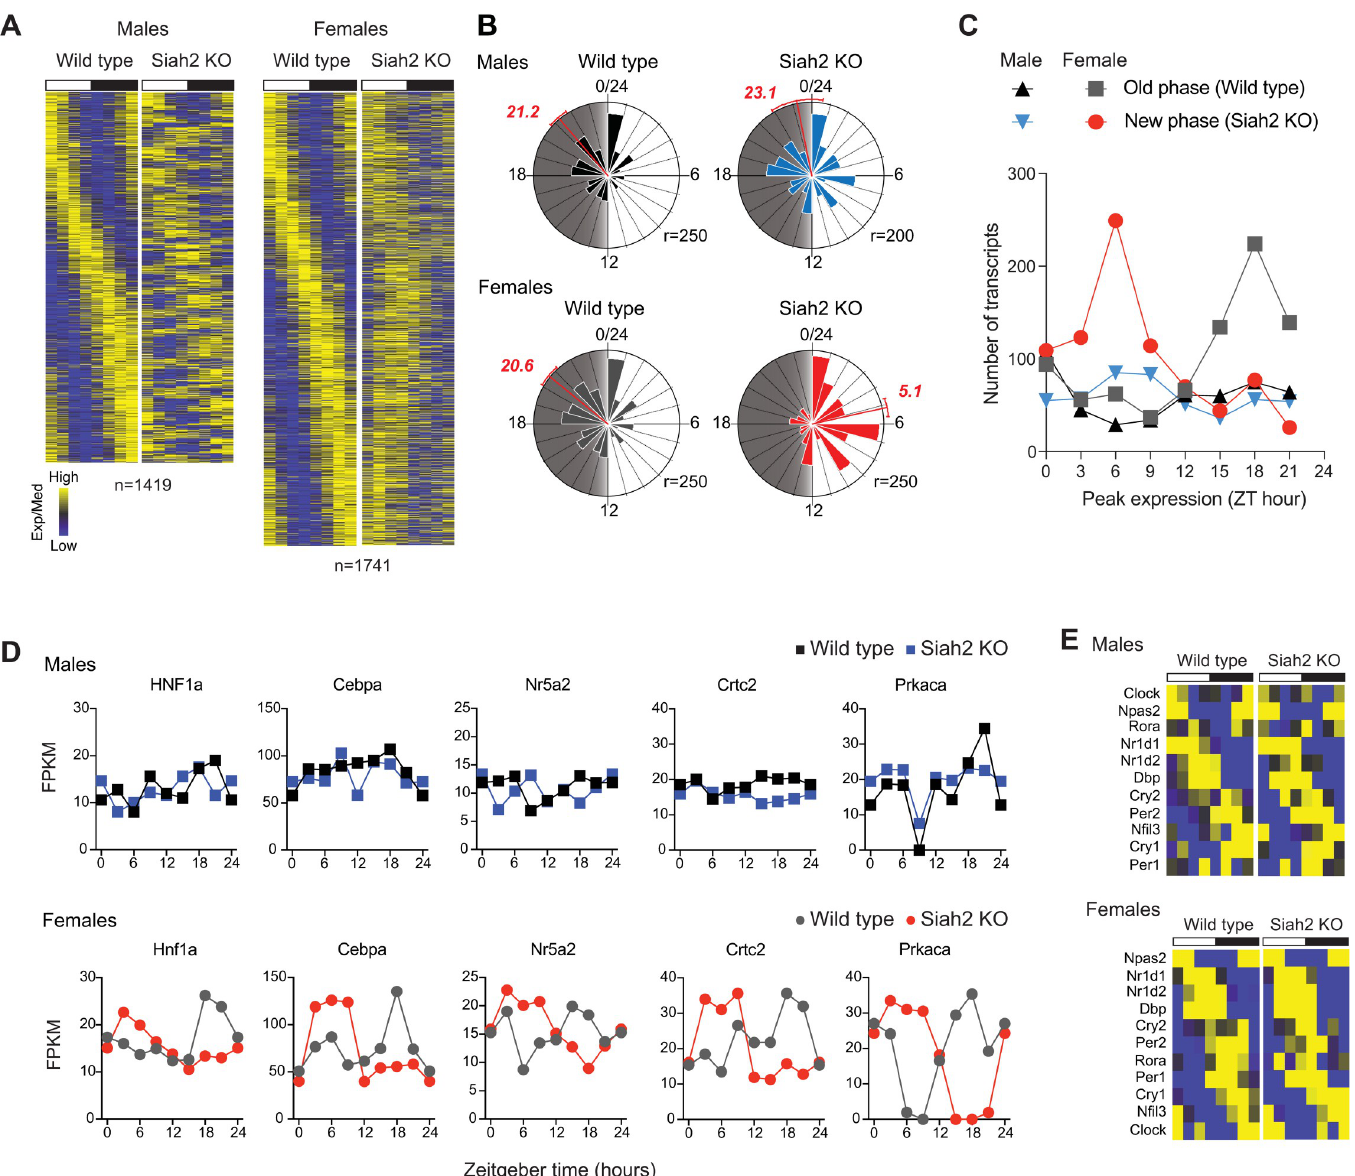
Fig 3. SIAH2 loss in females shifts rhythmic gene expression profiles from night to day. ( A ) Heatmaps of genes that were rhythmically expressed in both genotypes; genes are aligned across genotypes (but not across sex). ( B ) Raleigh plots of the peak expression phase for the genes in A. Plotted as decribed for Fig 2B. ( C ) Frequency distributions of peak phase across time of day for genes rhythmically expressed in both genotypes but shifted by more than 6 hours between genotypes. See also S1 Fig and S2 and S3 Datasets . ( D ) Heatmaps depicting similar rhythmic expression of core circadian clock genes across all four groups. ( E ) Example gene expression profiles of genes across all four